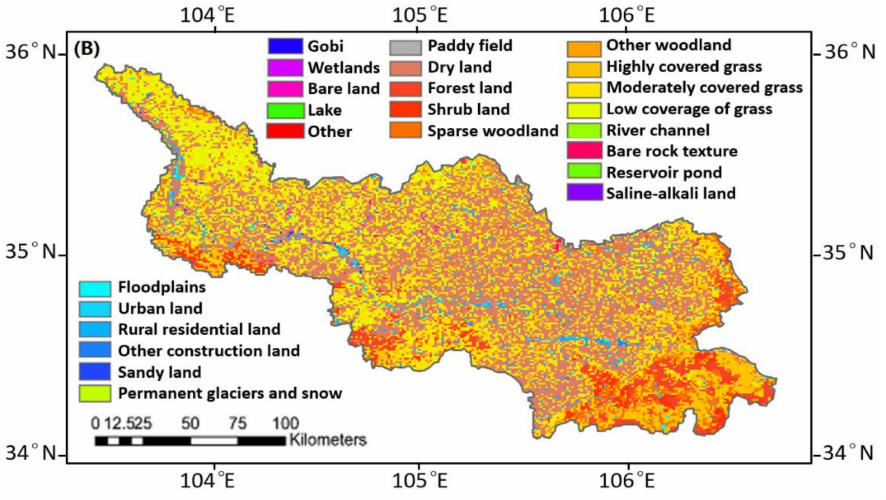
Figure 8. Land use in the upper reaches of the Weihe River Basin in 1980 ( A ) and 2015 ( B ).